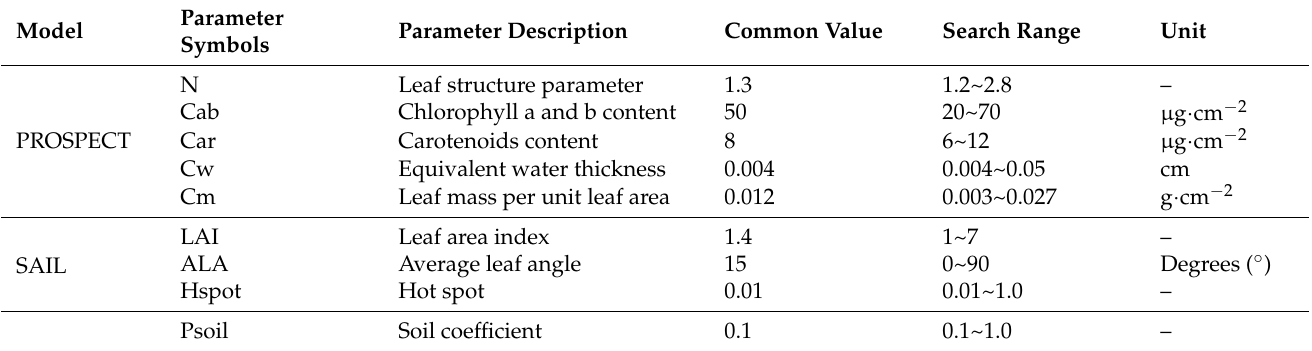
Table 2. Main input parameters of the PROSAIL model.